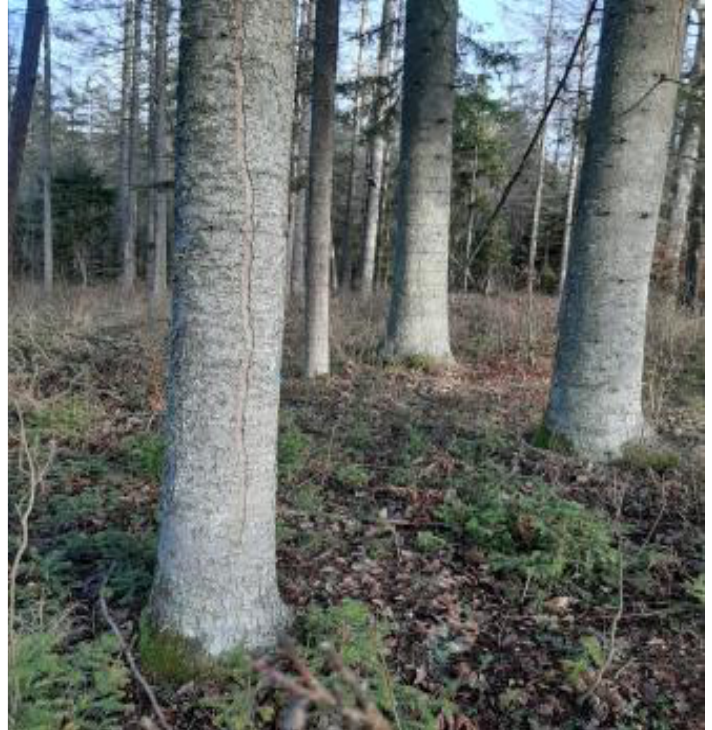
Figure 11. Biogroup of old firs in the Polish part of Białowieża FD (subdistrict Grudki, subcompartment 498 Ci) (photo by A. Marozau).